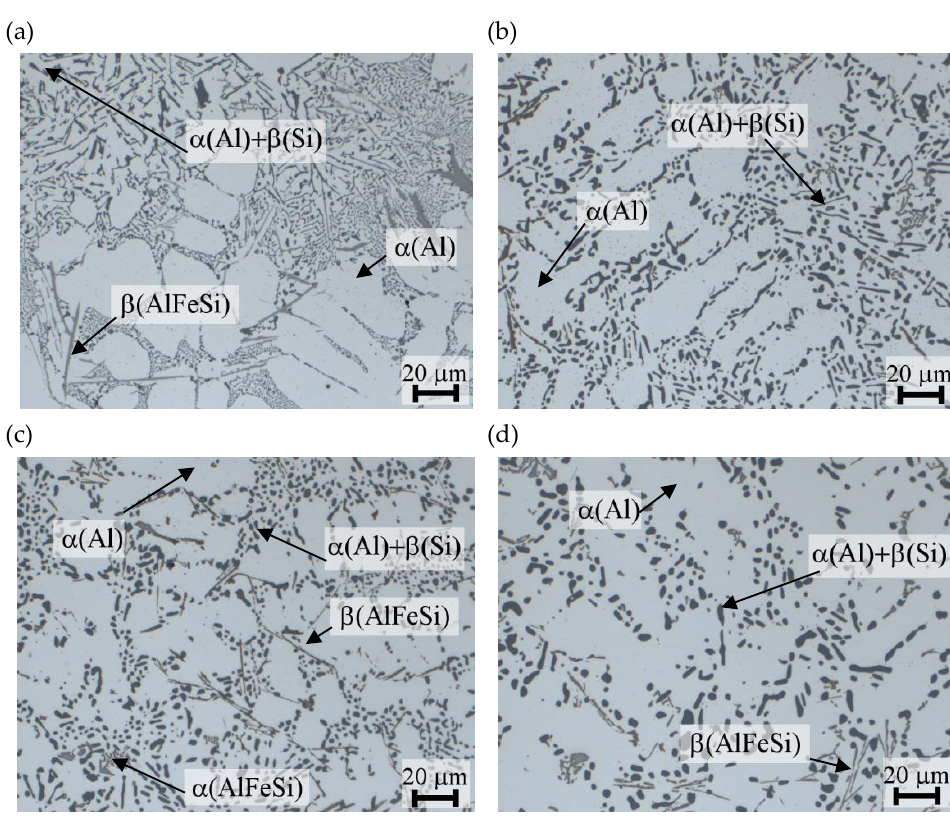
Figure 13. EN AC-AlSi11(Fe) alloy microstructure in the ( a ) initial state and after T6 heat treatment performed according to the test plan combination nos. ( b ) 9 ( t p = 475 °C, τ p = 4.5 h, t s = 280 °C, τ s = 6 h), ( c ) 13 ( t p = 505 °C, τ p = 2.5 h, t s = 165 °C, τ s = 4 h), ( d ) 25 ( t p = 545 °C, τ p = 4.5 h, t s = 165 °C, τ s = 6 h).